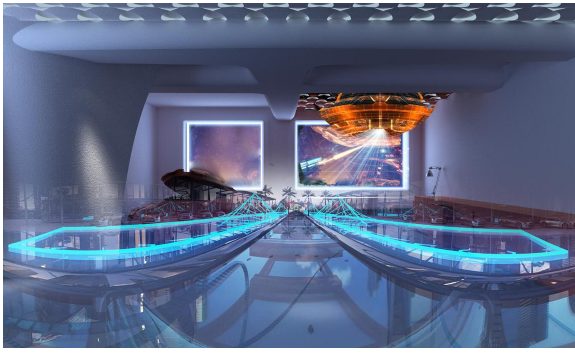
Fig. 2. Example of personal preference